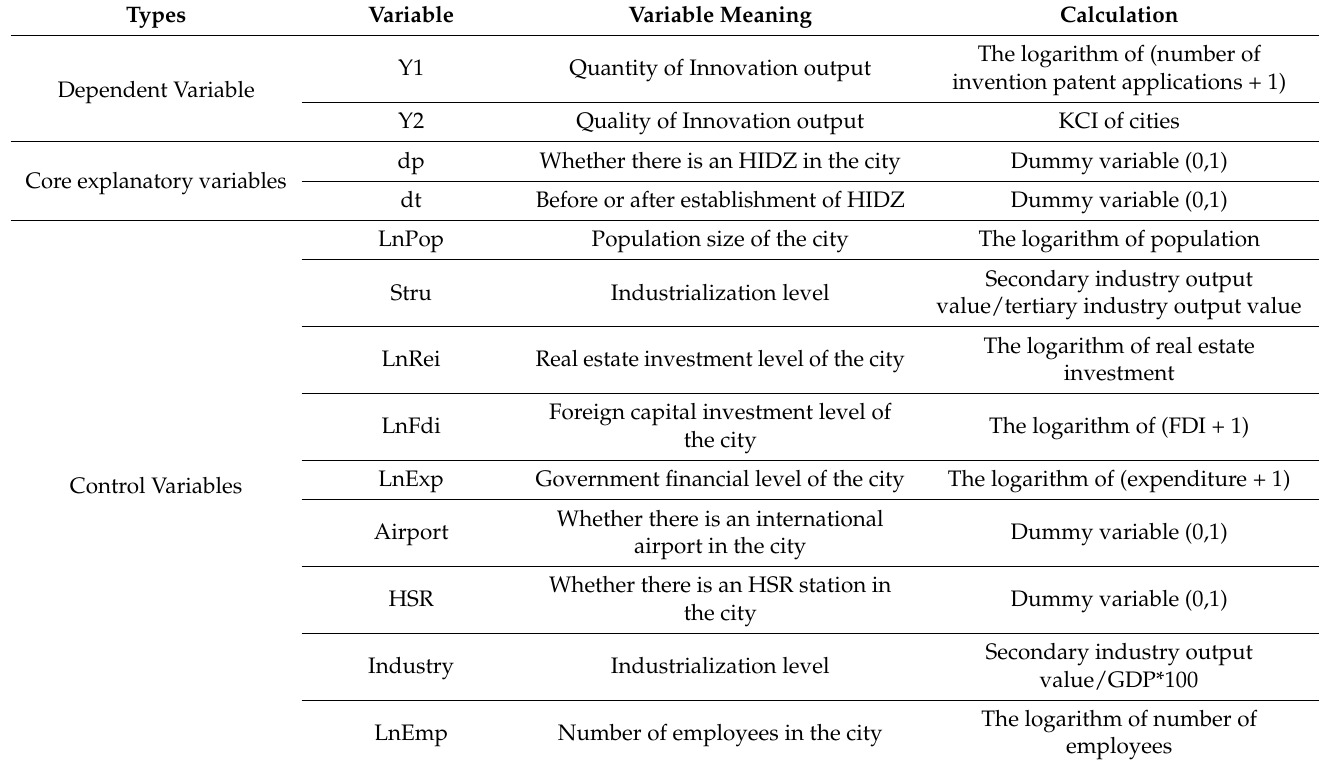
Table 1. The variables in PSM-DID model and their calculation